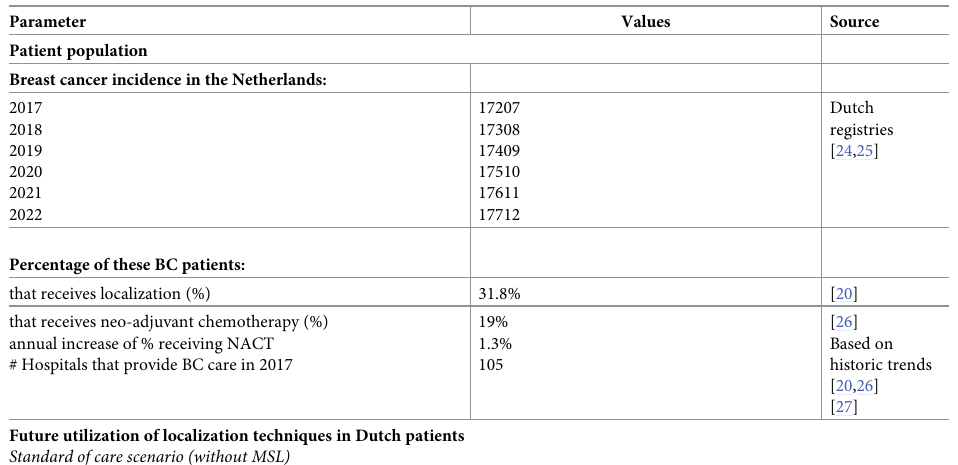
Table 1. Input parameters for the Budget Impact Analysis